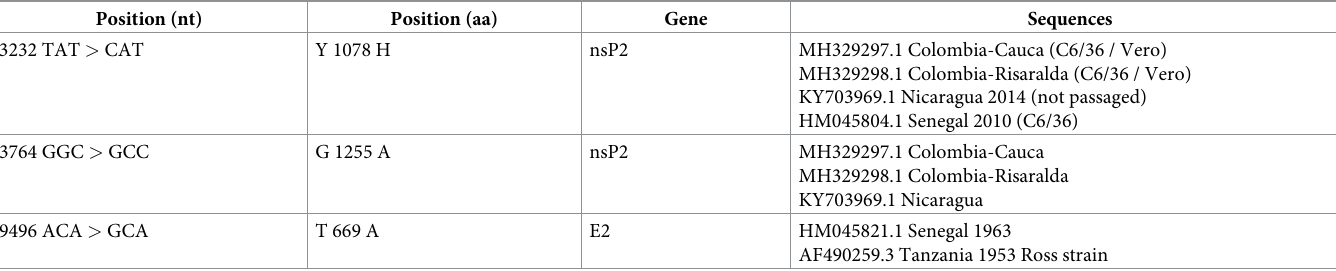
Table 1. Amino acid substitutions distinctive of COL7624 Colombian CHIKV isolate. Position